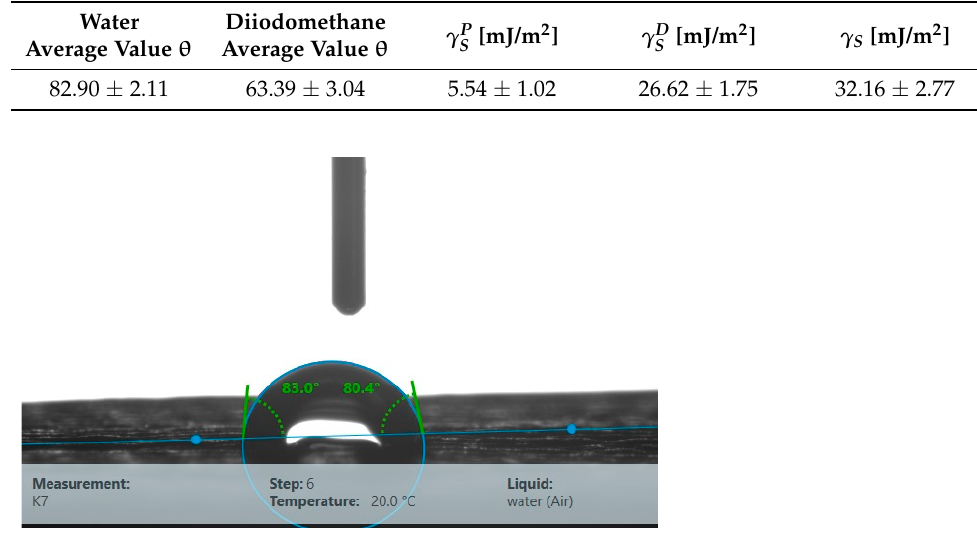
Figure 6. Determination of the contact angle of Mikasa. Table 2. The surface free energy for the Mikasa sample. Water Average Value θ